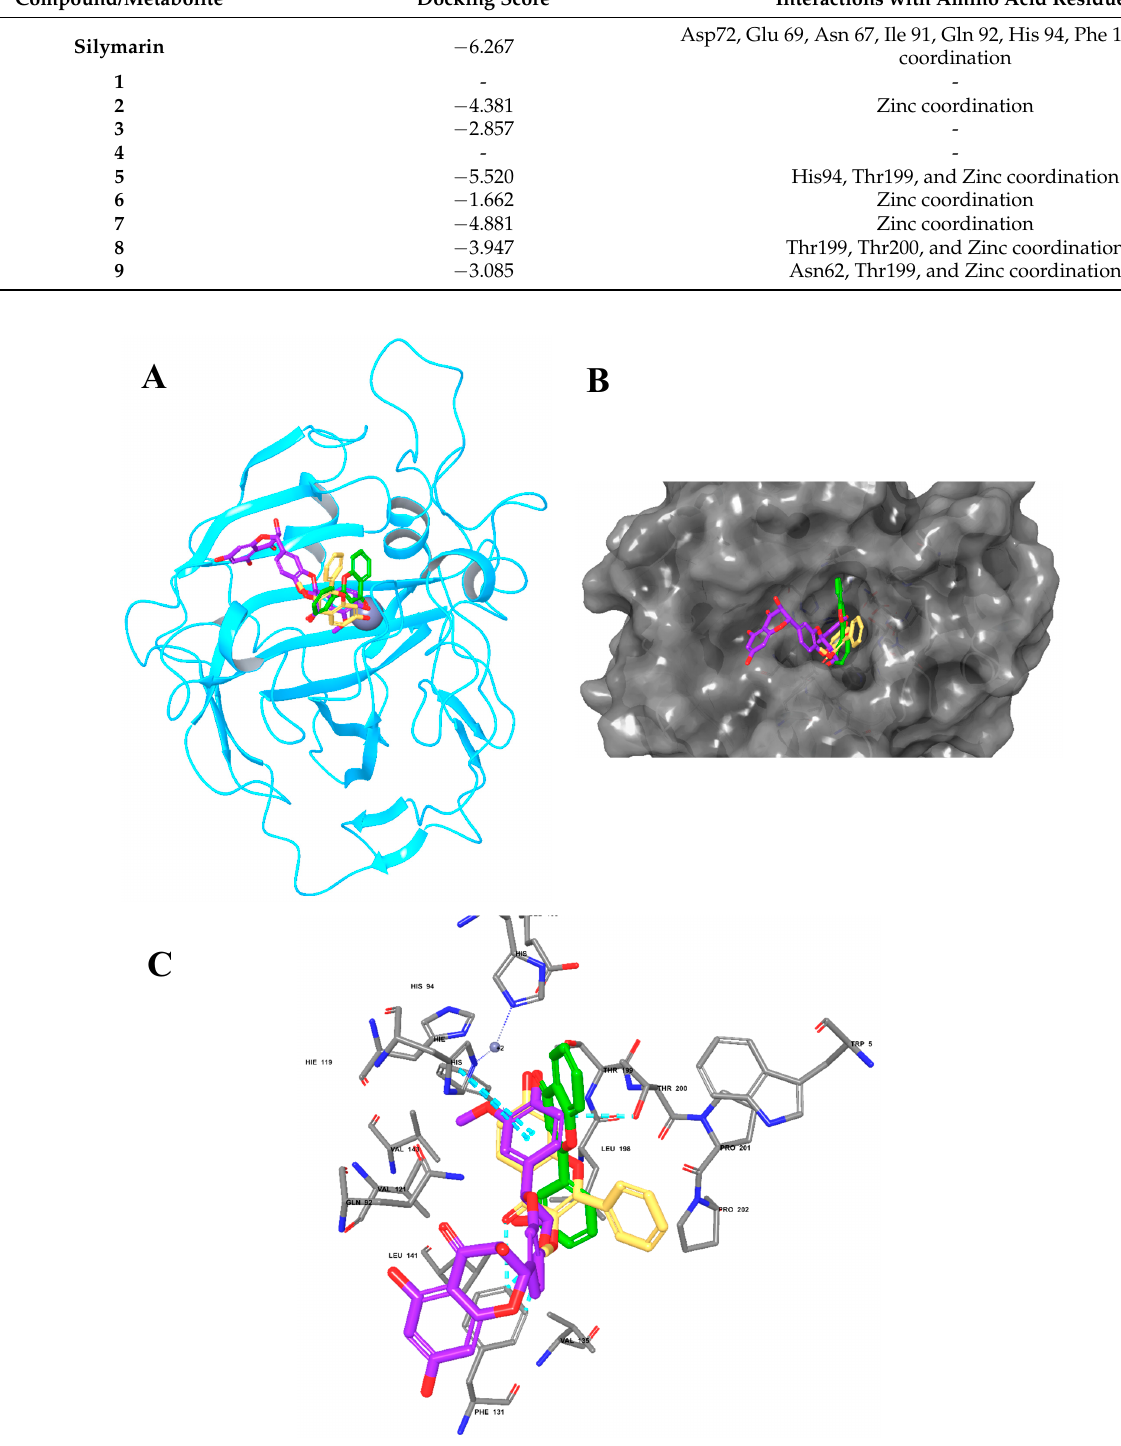
Figure 6. The molecular docking of Silymarin and BERM-derived Metabolites into CA II Enzyme . ( A ) Overlay of Silymarin (Violet), Metabolite 5 (faded orange) and Metabolite 7 (green) in the binding pocket of CA II enzyme; ( B ) surface representation of CA II enzyme with the docked Metabolites occupying the binding pocket; ( C ) the molecular interactions of Silymarin (Violet), Metabolite 5 (faded orange), and Metabolite 7 (green) with the amino acids in the binding site.